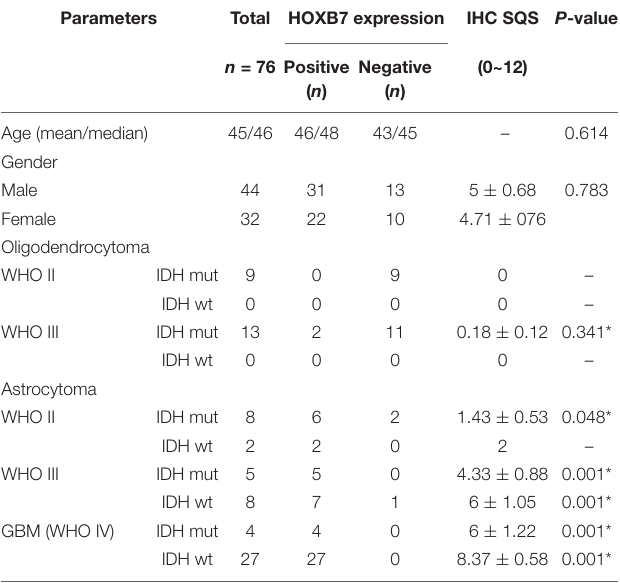
TABLE 1 | Clinical characteristics and homeobox B7 (HOXB7) protein expression. Parameters